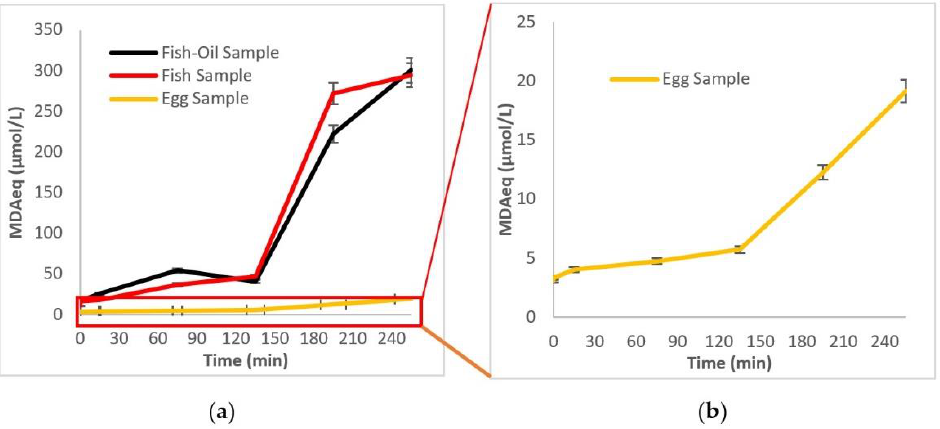
Table values are means ± standard deviations. Different superscript letters in the same row represent statistical differences ( p ≤ 0.05); n represents the number of independent experiment replications.